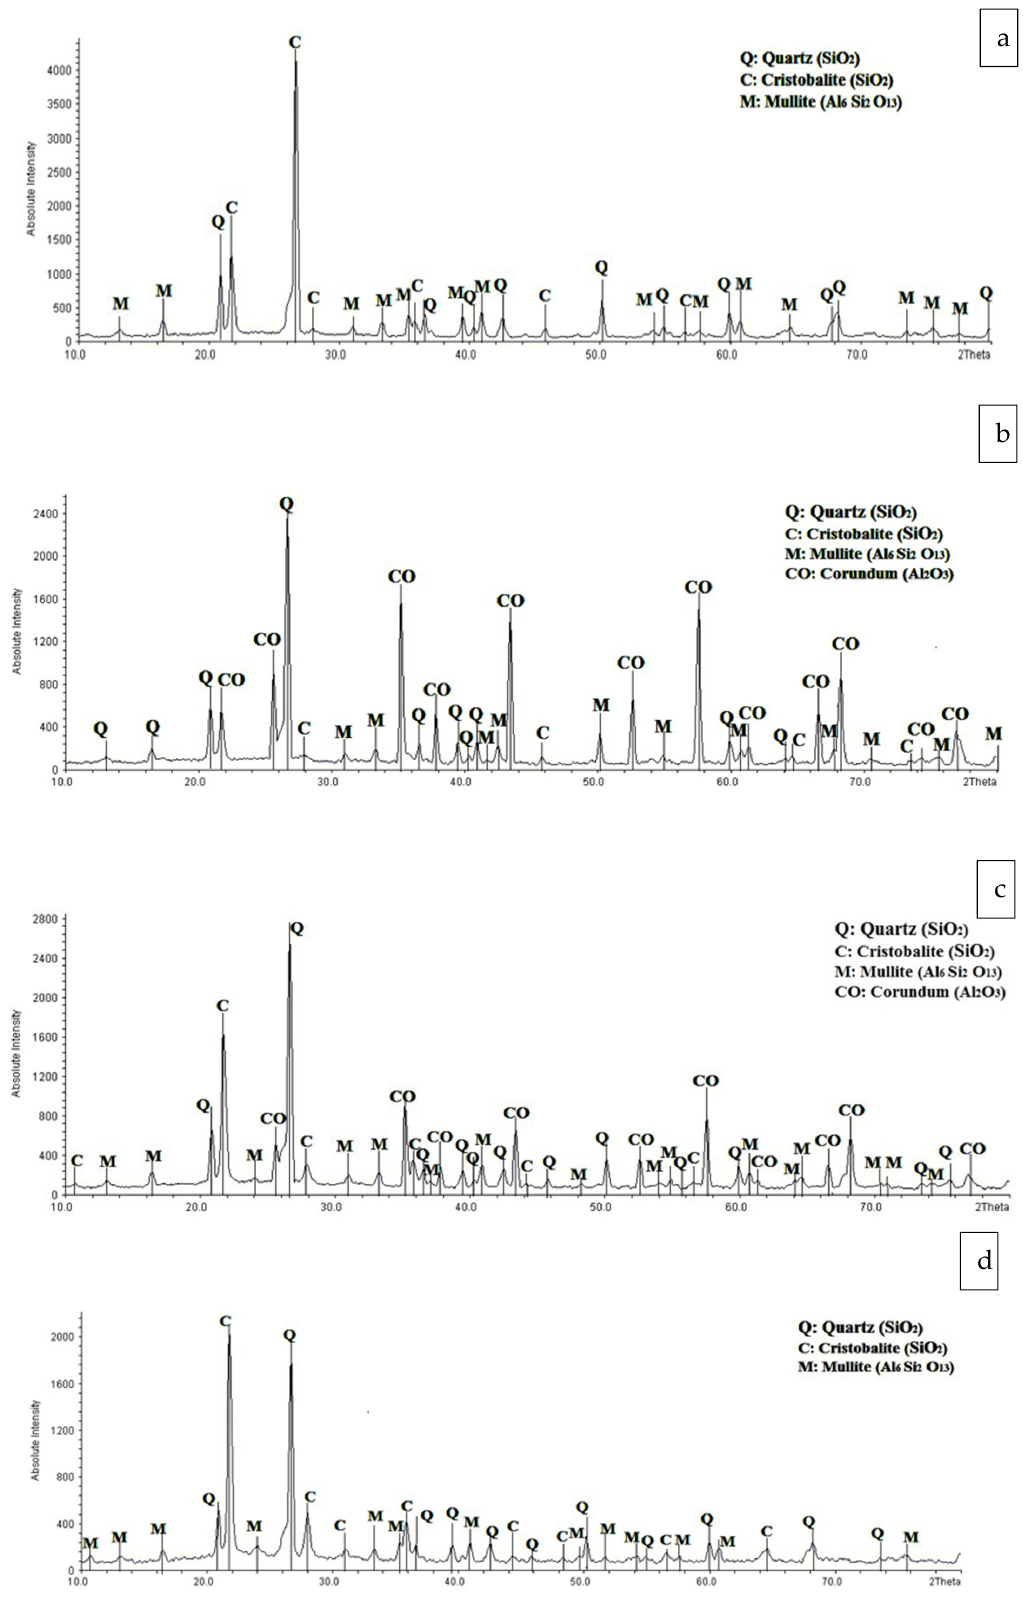
Figure 7. XRD pattern of prepared ceramic membranes after sintering ( a ) mullite ( b ) mullite-alumina ( c ) mullite-alumina-zeolite ( d ) mullite-zeolite.